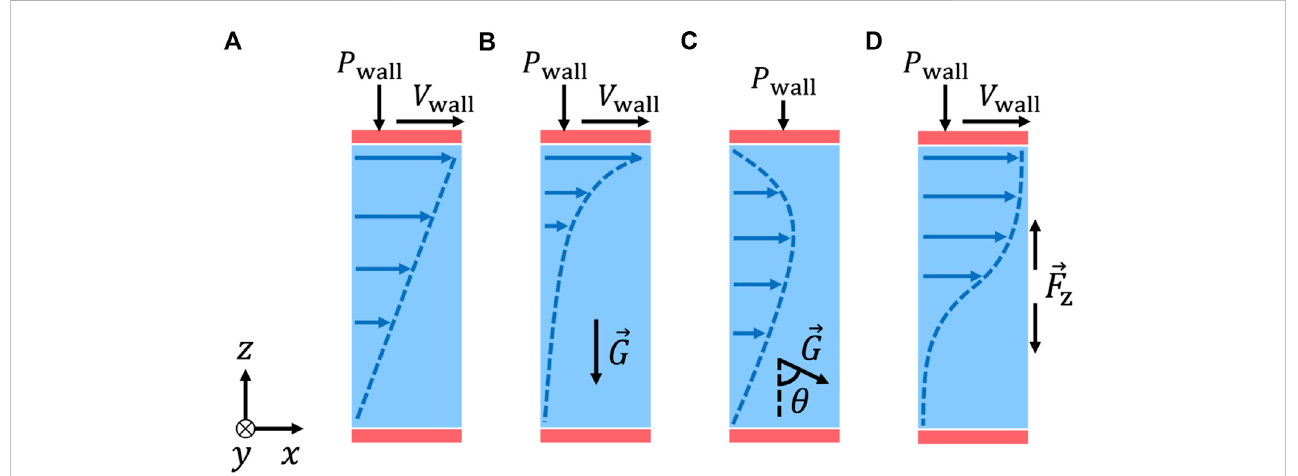
FIGURE 2 Schematicdiagramsofplanarshear fl owsusedformodelcalibrationinSection2: (A) simpleshear, (B) shearwithgravity, (C) chute fl ows( θ =60 ° and90 ° ), and (D) concave fl ows. Red rectangles represent wall particles whose velocities are set to form rigid walls. Dashed lines indicate velocity pro fi les. x is the fl ow direction, y is the vorticity direction, and z is the velocity gradient